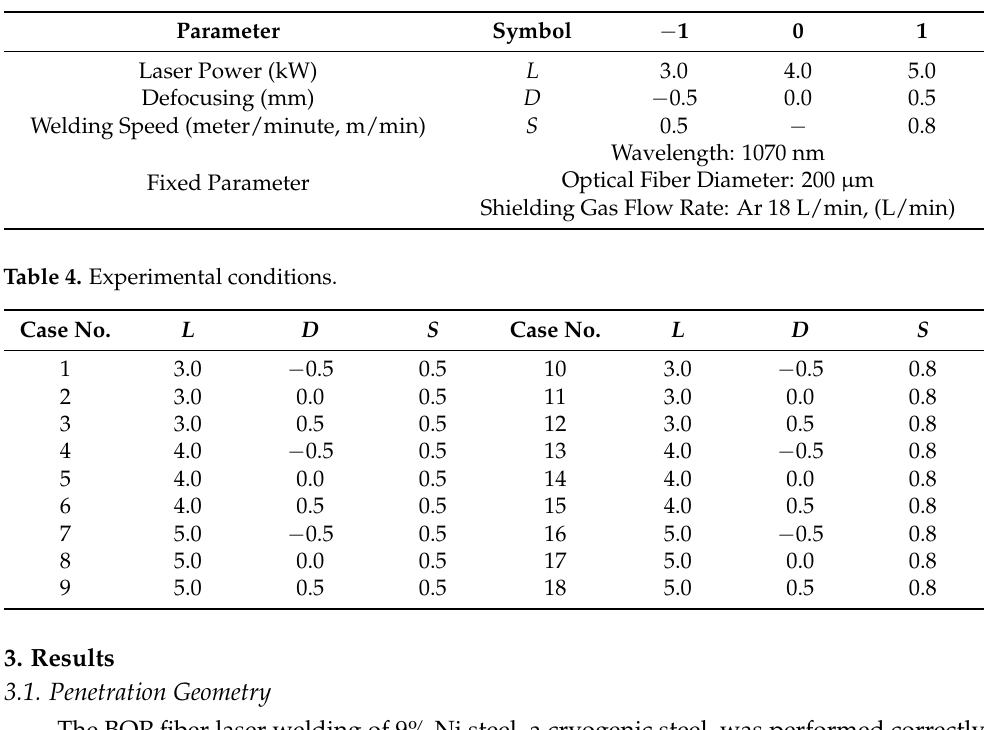
Table 3. Parameters and levels of fiber laser welding.